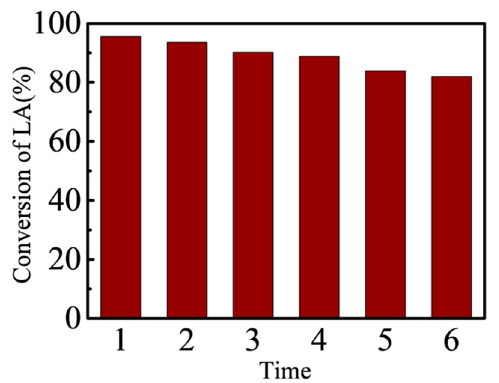
Figure 12. Reusability of the nano-catalyst operated at reaction temperature: 90 °C reaction time: 5 h, and catalyst mass: 0.116 g.